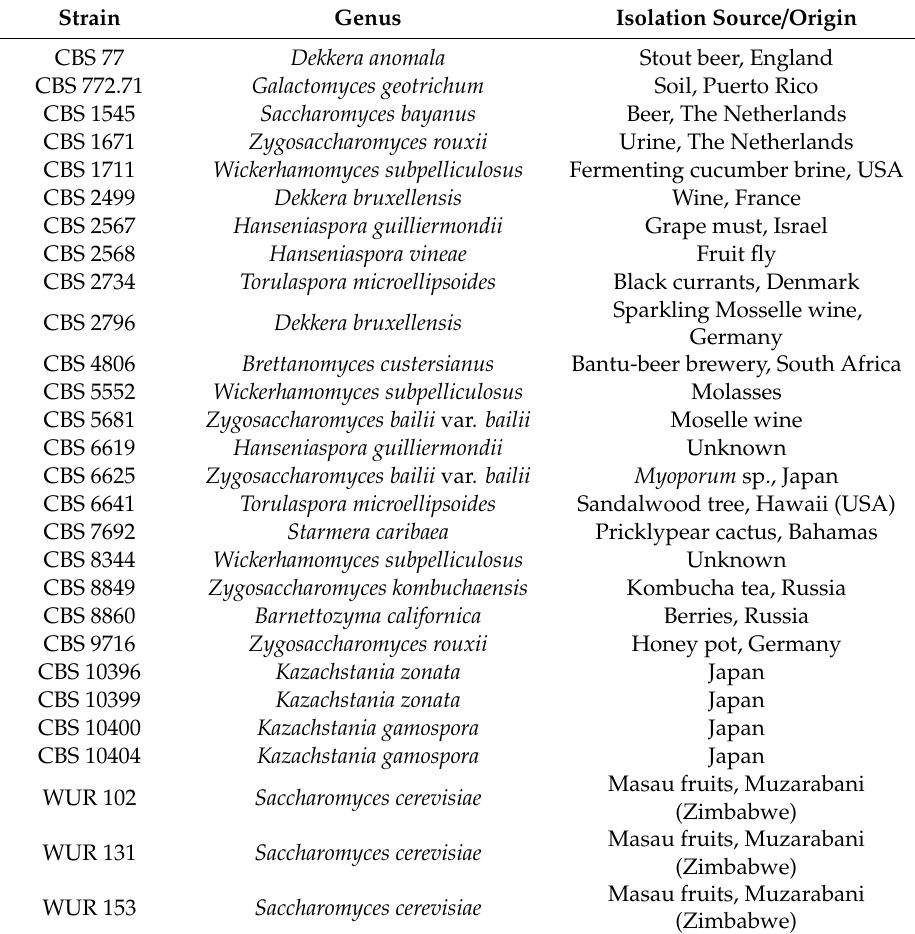
Table 1. Yeast strains employed in this